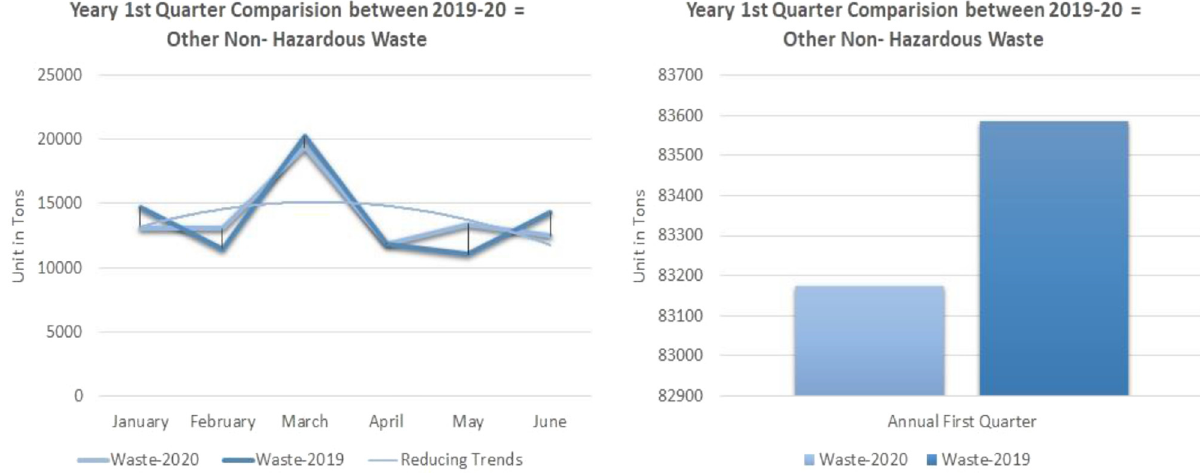
Fig. 9. Comparison of the amount of non-hazardous waste (2019 – 2020) (Ajman (cid:1) UAE) [15].